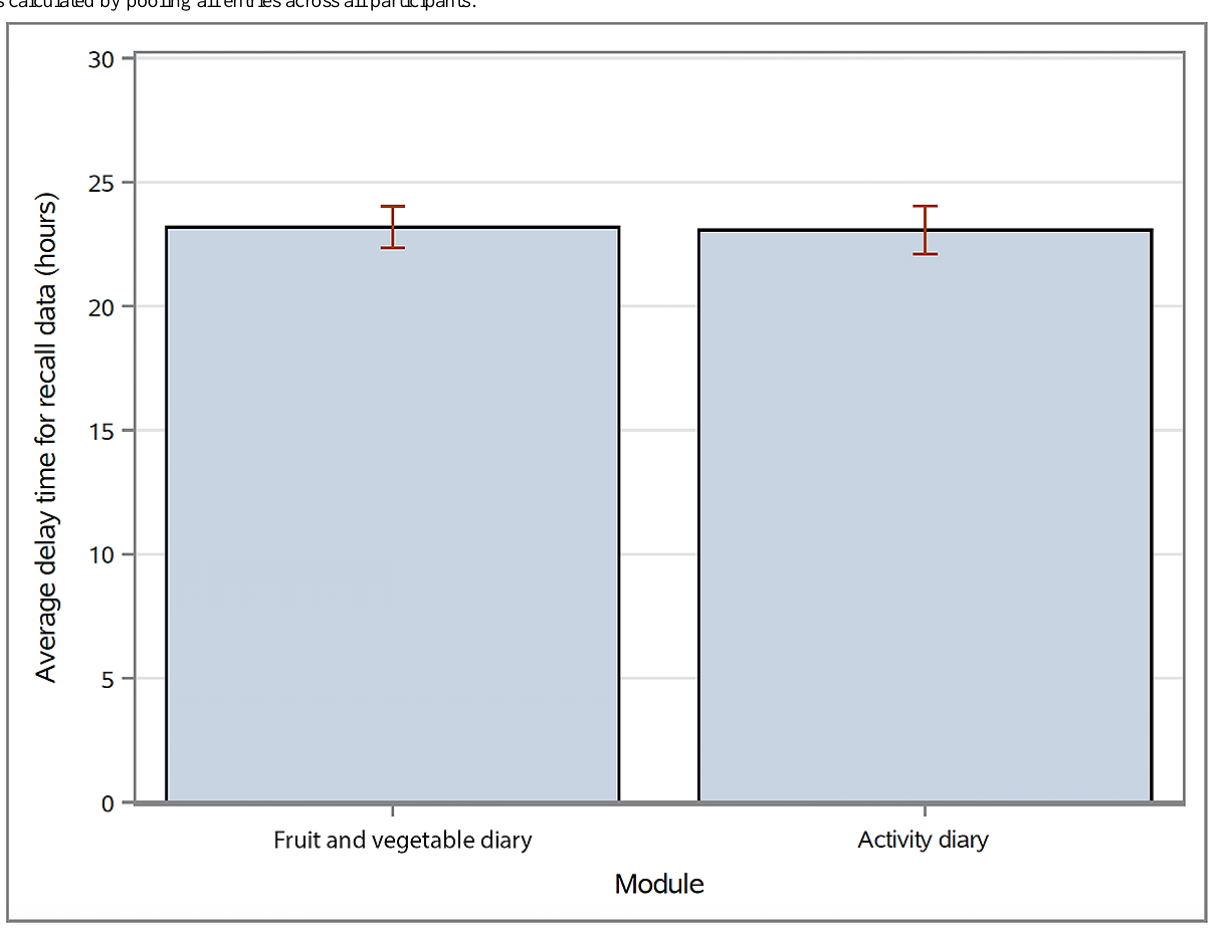
Figure 9. Average time participants took to enter a diary entry after the actual diary date. Error bars represent UCLM and LCLM. The average time was calculated by pooling all entries across all